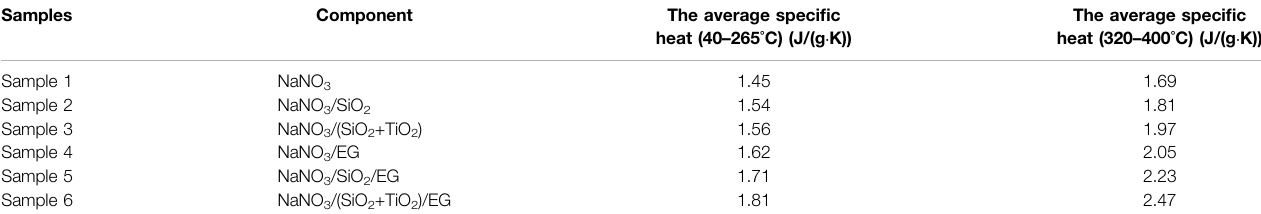
TABLE 3 | The speci fi c heat of different samples. Samples